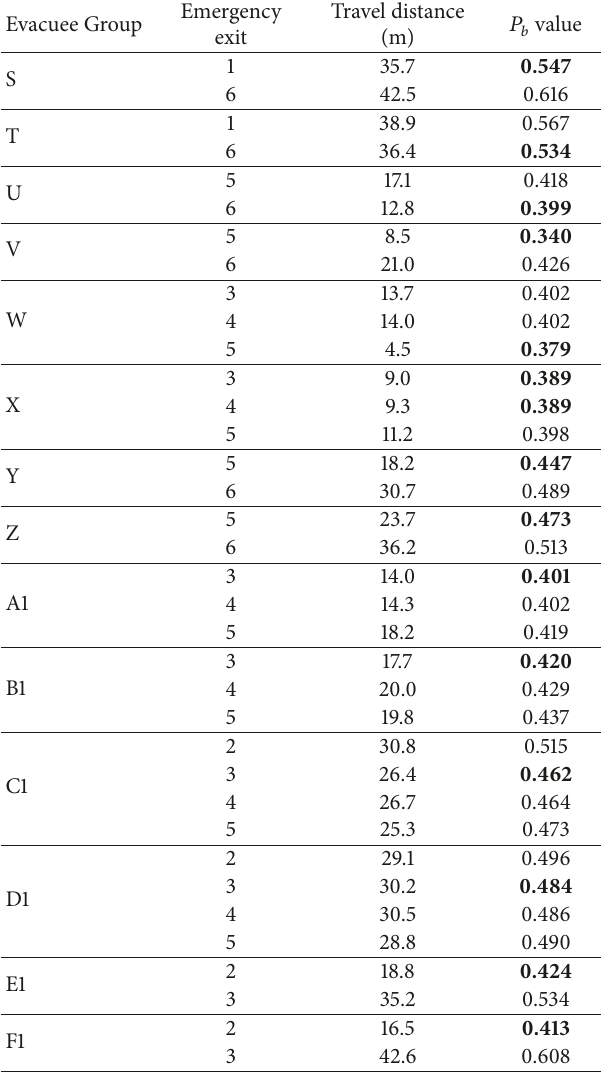
Table 5: Summary of all routing solutions. Evacuee